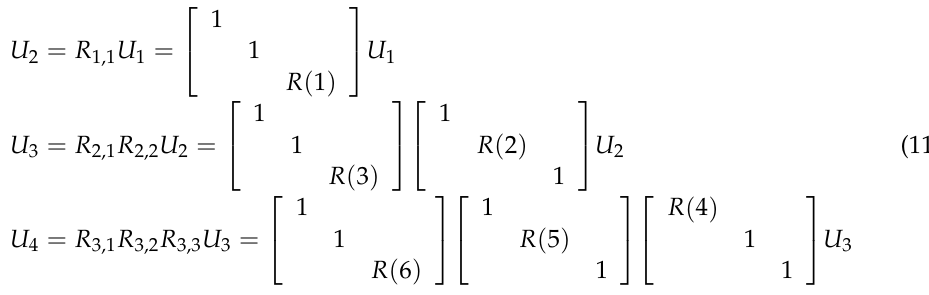
Figure 7. The principle of the MZI matrix core. ( a ) The structure of one MZI used in an MZI matrix core. ( b ) The whole MZI mesh consists of MZI matrix cores, and MZIs can be equivalent to a recon- figurable black box. ( c ) A typical example of a 4 × 4 network structure enabled by an MZI matrix core.